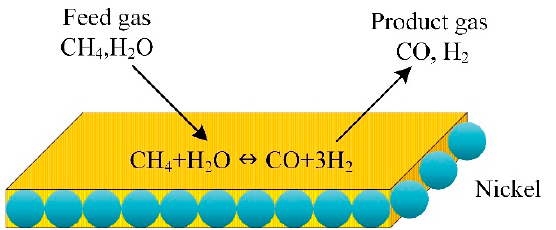
Figure 9. Schematic illustration of methane catalytic steam reforming [91].